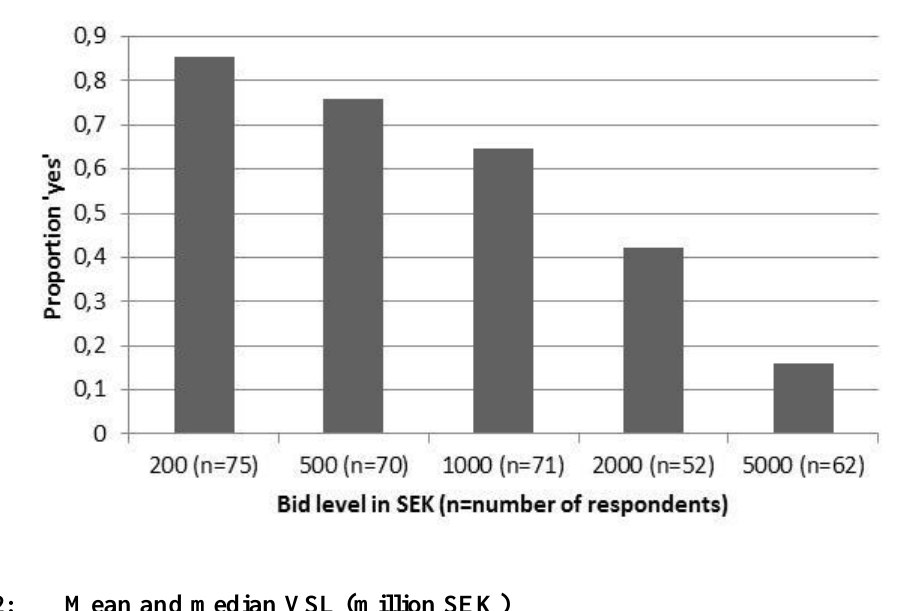
Figure 1: Proportions of yes-responses by bid amount